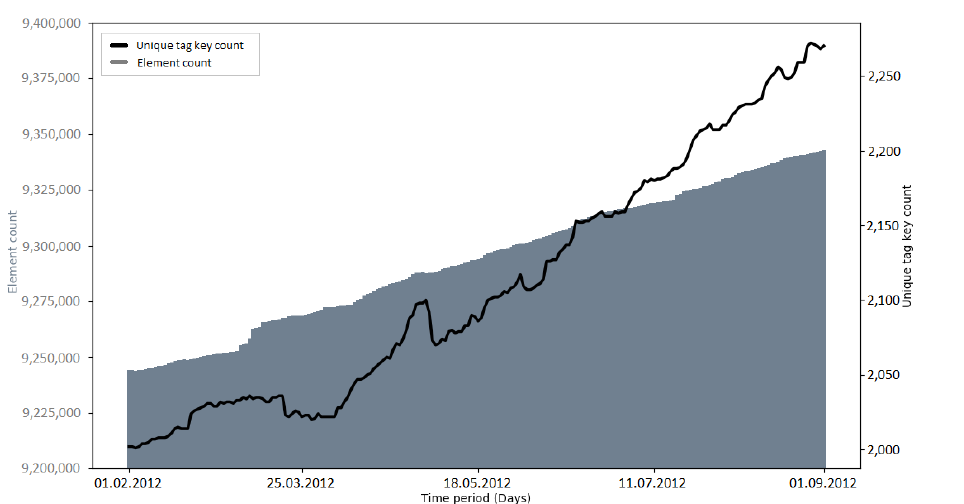
Figure A19. Number of tag keys during the observation period without a large data import in the Netherlands.